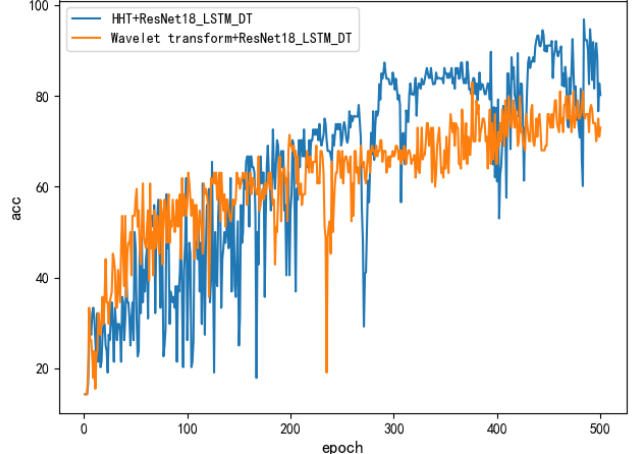
Figure 15. The hybrid model identification effect obtained by combining two time–frequency anal- ysis methods,